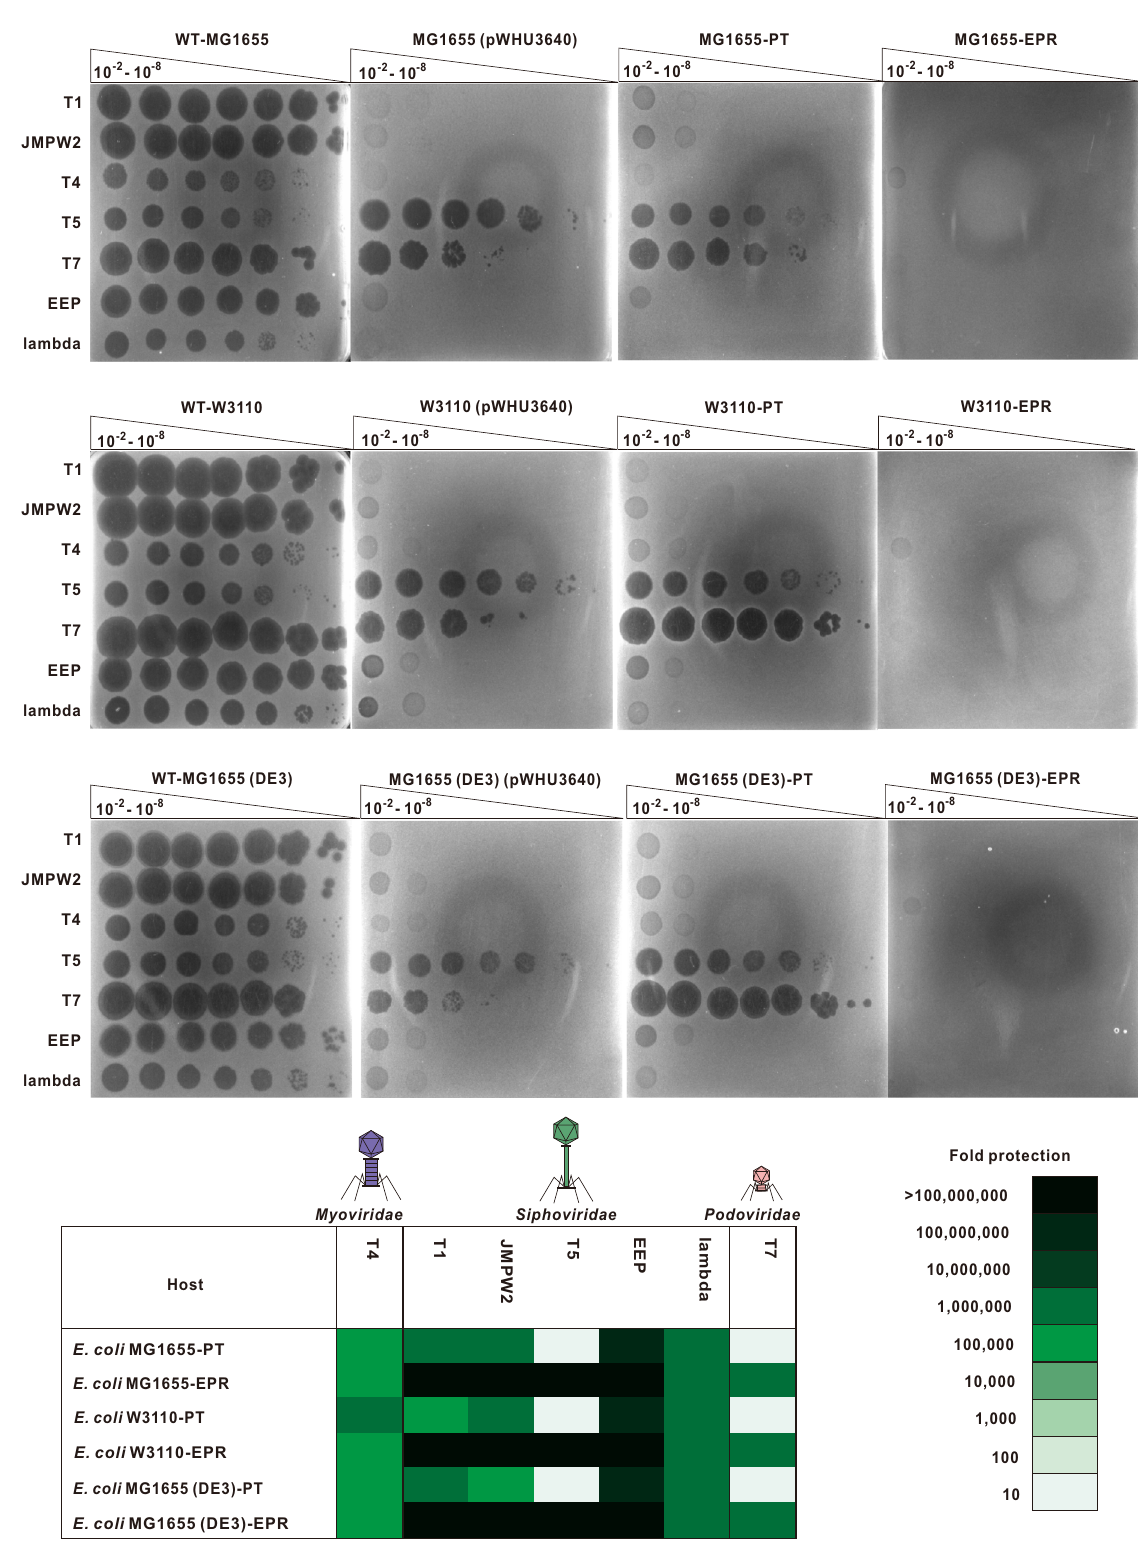
Fig. 2 Construction of engineered phage-resistant (EPR) E. coli strains. a – c Phage plaque assays were used to compare the phage infection ef fi ciencies in WT-MG1655, MG1655 carrying pWHU3640, MG1655-PT and MG1655-EPR strains ( a ); in WT-W3110, W3110 carrying pWHU3640, W3110-PT and W3110-EPR strains ( b ); and in WT-MG1655 (DE3), MG1655 (DE3) carrying pWHU3640, MG1655 (DE3)-PT and MG1655 (DE3)-EPR strains ( c ). The results are representative of three independent experiments. d The systematic genome engineering strategy confers strong phage resistance on different E. coli hosts. EOPs were determined to assess the protection levels of E. coli -PT and E. coli -EPR strains against coliphages. All the data were obtained at least three times. Source data are provided as a Source Data fi